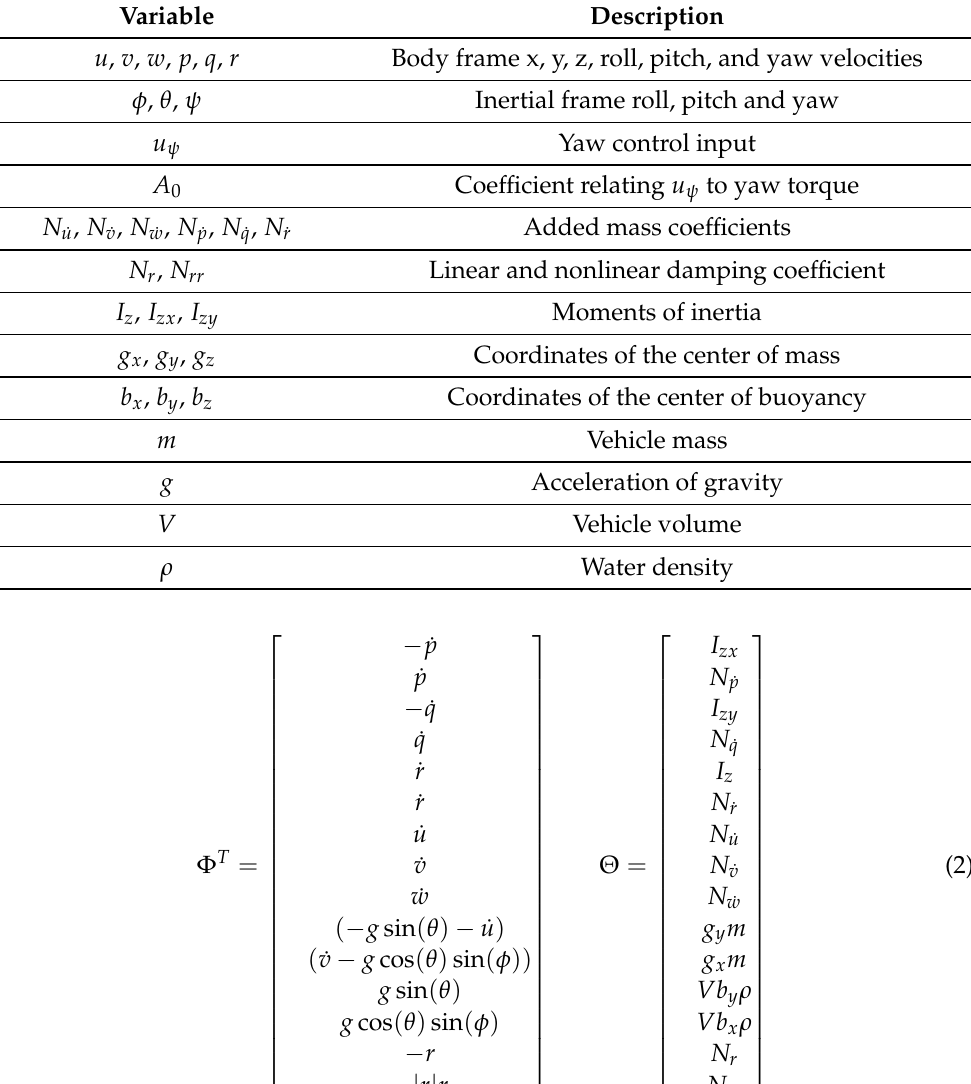
Table 1. Variable